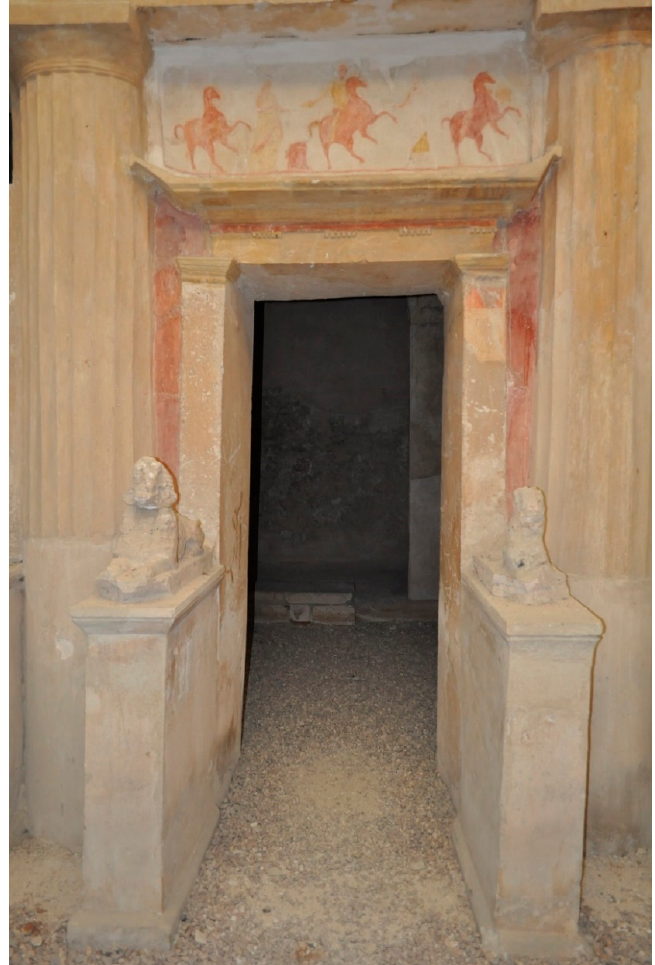
Figure 8. View of the central doorway in the south wall of the courtyard, Moustapha Kamel Tomb I, Alexandria. Photograph courtesy of Kyriakos Savvopoulos.